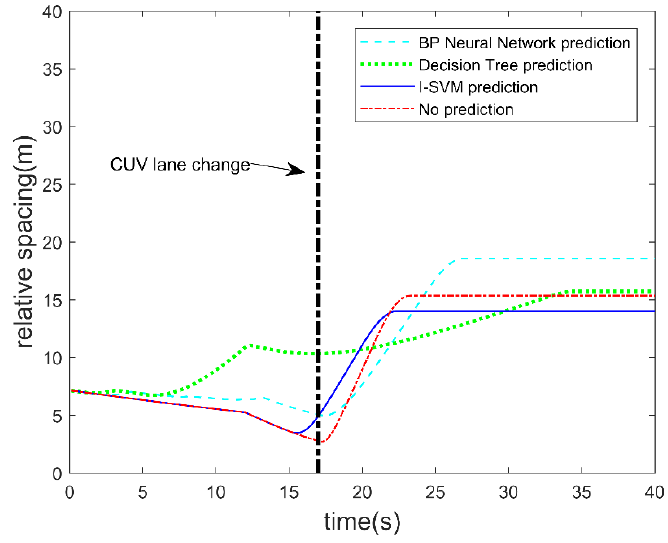
Figure 10. Distance between the autonomous vehicle and the CUV.